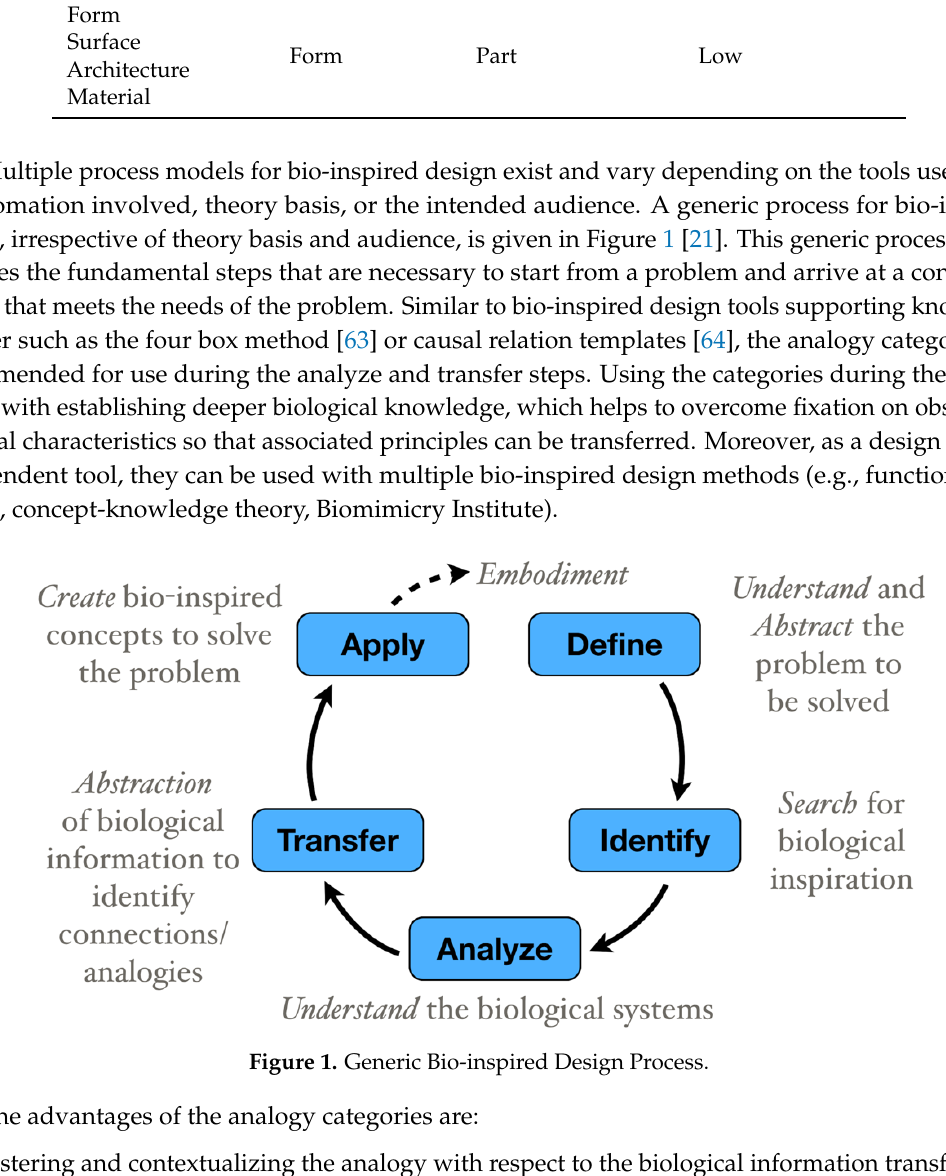
Table 2. Analogy Categories Compared to Supporting Work. Proposed Model Mak and Shu Chakrabarti et al. Abstraction Level Organ Principle